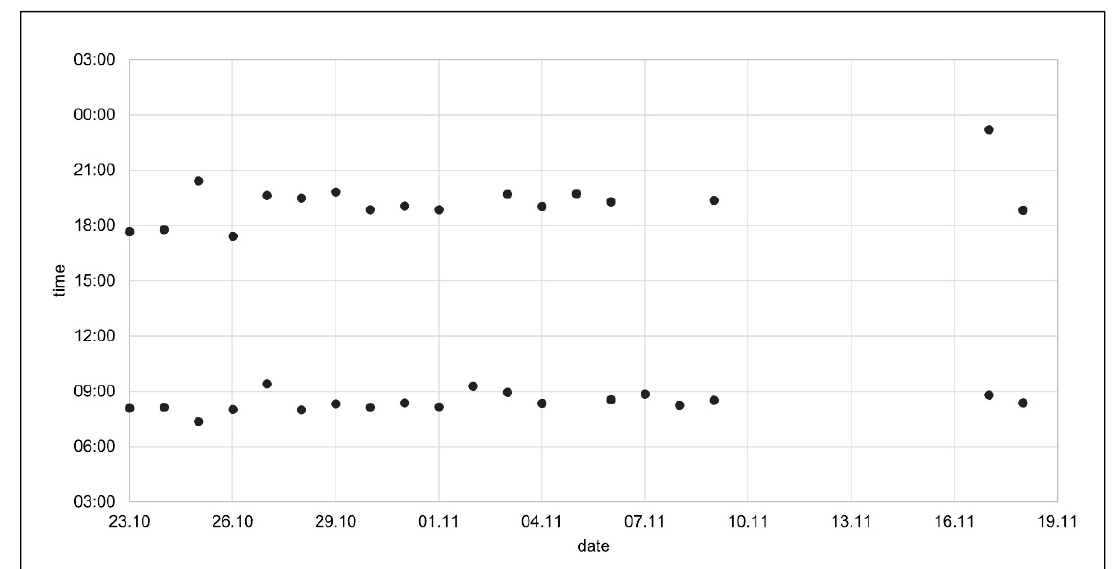
Figure 2. Dot chart displaying the electronically monitored medication adherence data of a twice daily regimen of apixaban over four weeks.